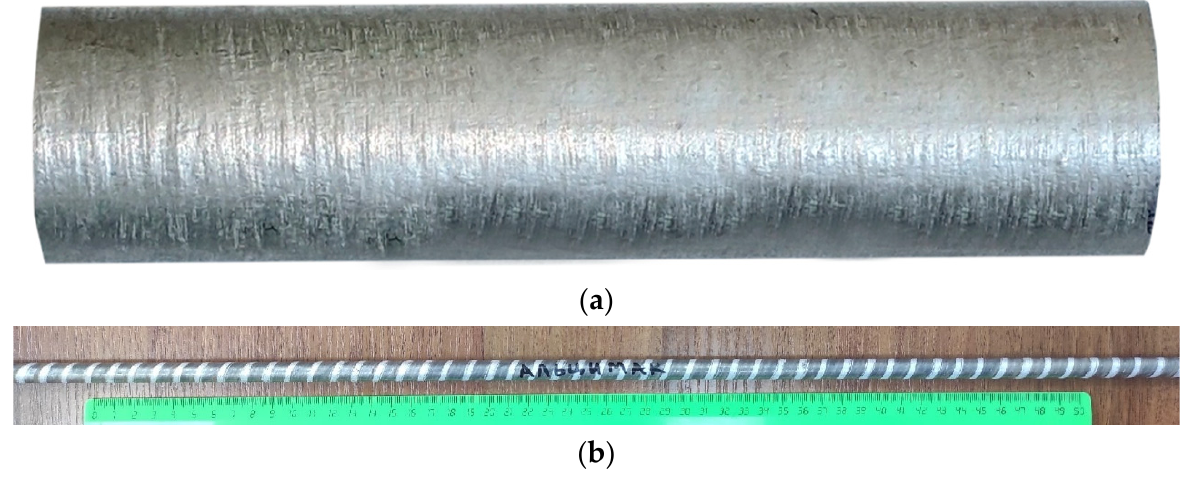
Figure 2. Ingot of the experimental alloy manufactured by EMC ( a ) and the rod processed by RSR from the EMC ingot ( b ).